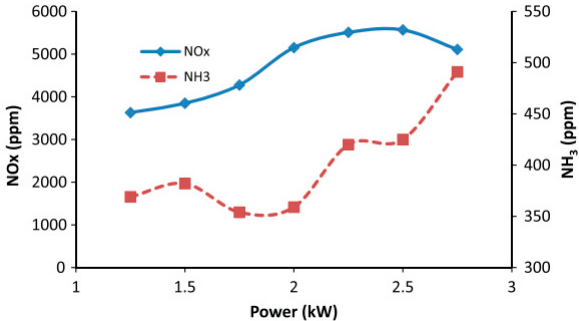
Figure 7. NOx and ammonia emissions at different power levels.